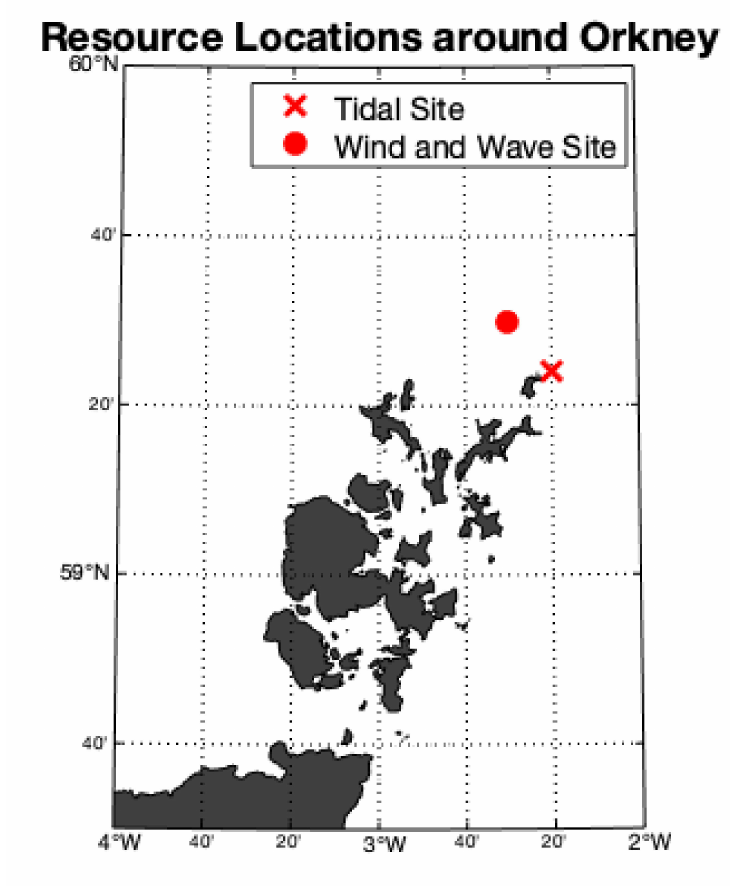
Figure 2. Resource sites colocated o ff North Ronaldsay, Orkney. Red markers indicate the location that data was collected from ECMWF ERA5 and FOAM AMM7 datasets for resource